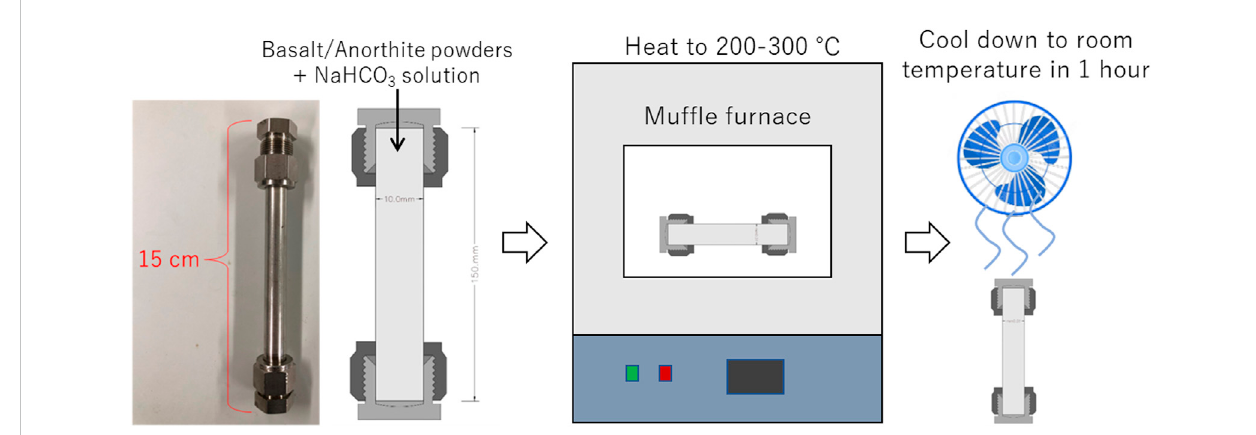
FIGURE 1 Schematic diagram of the closed batch reactor and reaction process. Note: the size shown in the schematic diagram is not proportional to the original size of the reactor.